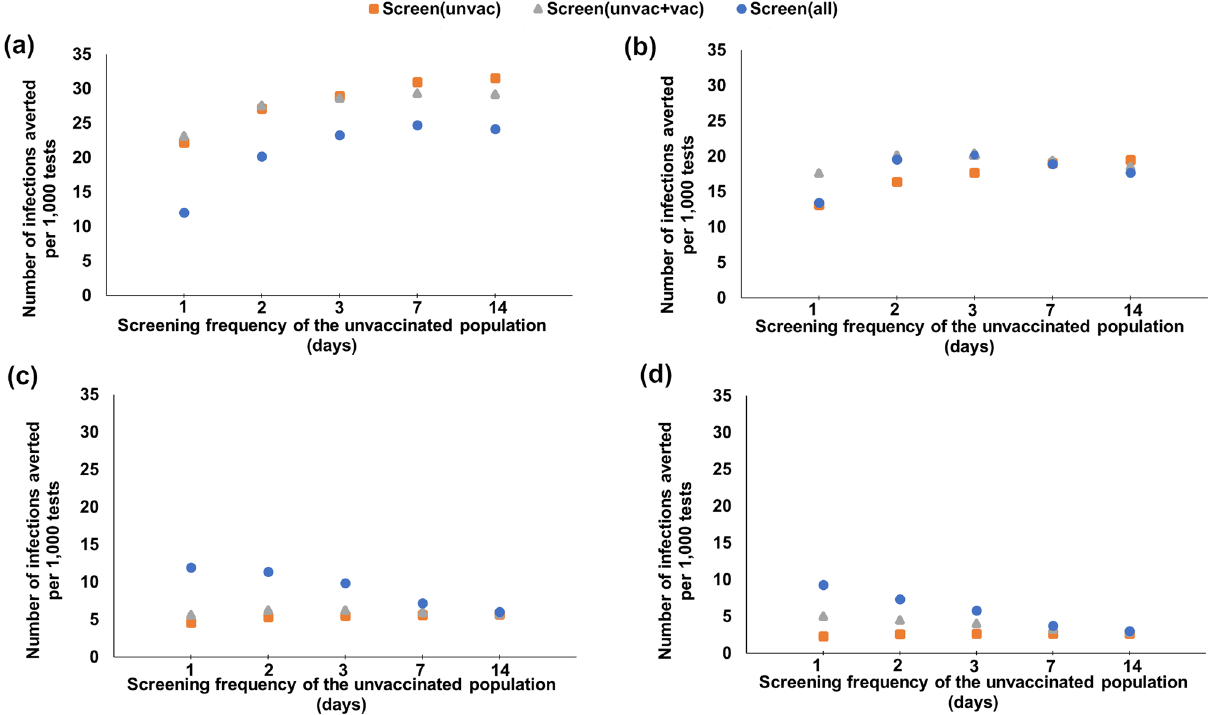
Figure 1. Number of infections averted per 1000 tests with respect to the screening frequency of the unvaccinated, for various universal and customized screening strategies under various booster and vaccination coverages and Omicron proportions. ( a ): ω O = 50% , 64% boosted, 18% vaccinated, 18% unvaccinated, ( b ): ω O = 50% , 38% boosted, 44% vaccinated, 18% unvaccinated, ( c ): ω O = 95% , 64% boosted, 18% vaccinated, 18% unvaccinated and ( d ): ω O = 95% , 38% boosted, 44% vaccinated, 18%